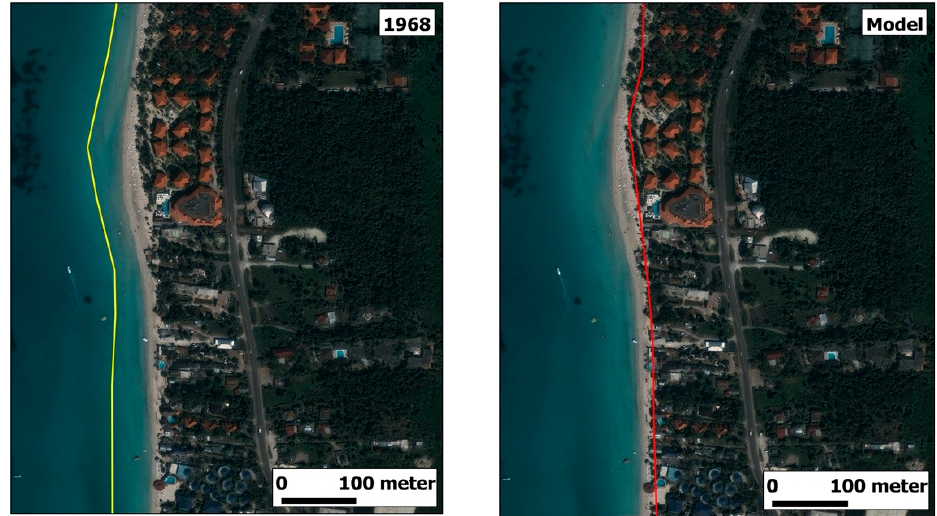
Figure 8. ( Left ): the yellow line shows where the beach was in 1968. ( Right ): the red line shows where the beach would be if all the ecosystems are removed (using our model and artificially replacing width of shallow coral and width of total sea grass by 0).